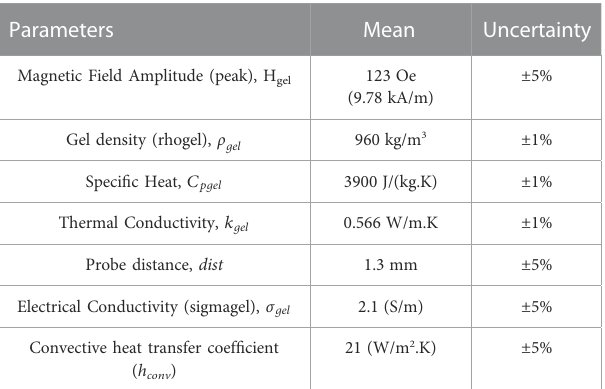
TABLE 1 Material properties used in FEA simulations for PID temperature feedback control. Data sourced from Sharma et al. (2023).